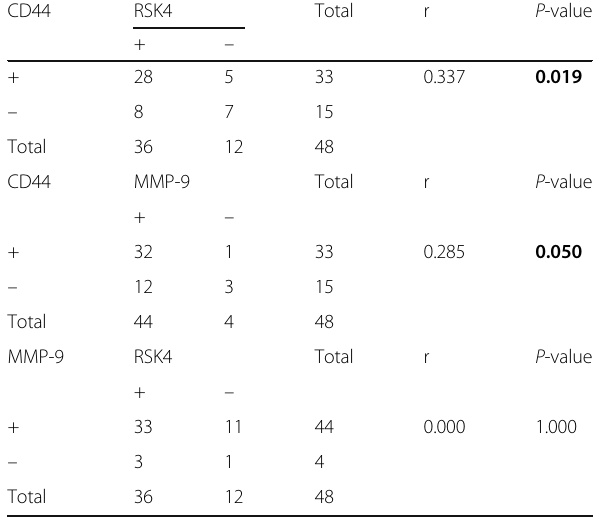
Table 2 Correlations of the expression levels of RSK4, CD44 and MMP-9 in